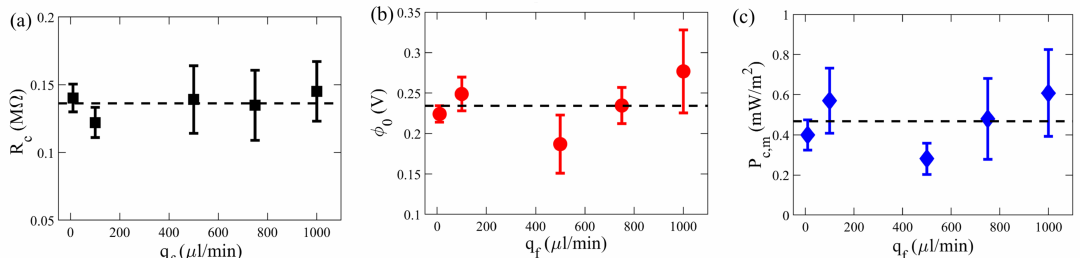
Figure 4. Insignificant variations of ( a ) internal resistance, R c , ( b ) open-circuit voltage, φ 0 , and ( c ) maximum power output density at ∆ c = 0.86 M under a wide range of flow rate, q f . The dashed lines in ( a – c ) represent the average value of R c , φ 0 and P c , m ,